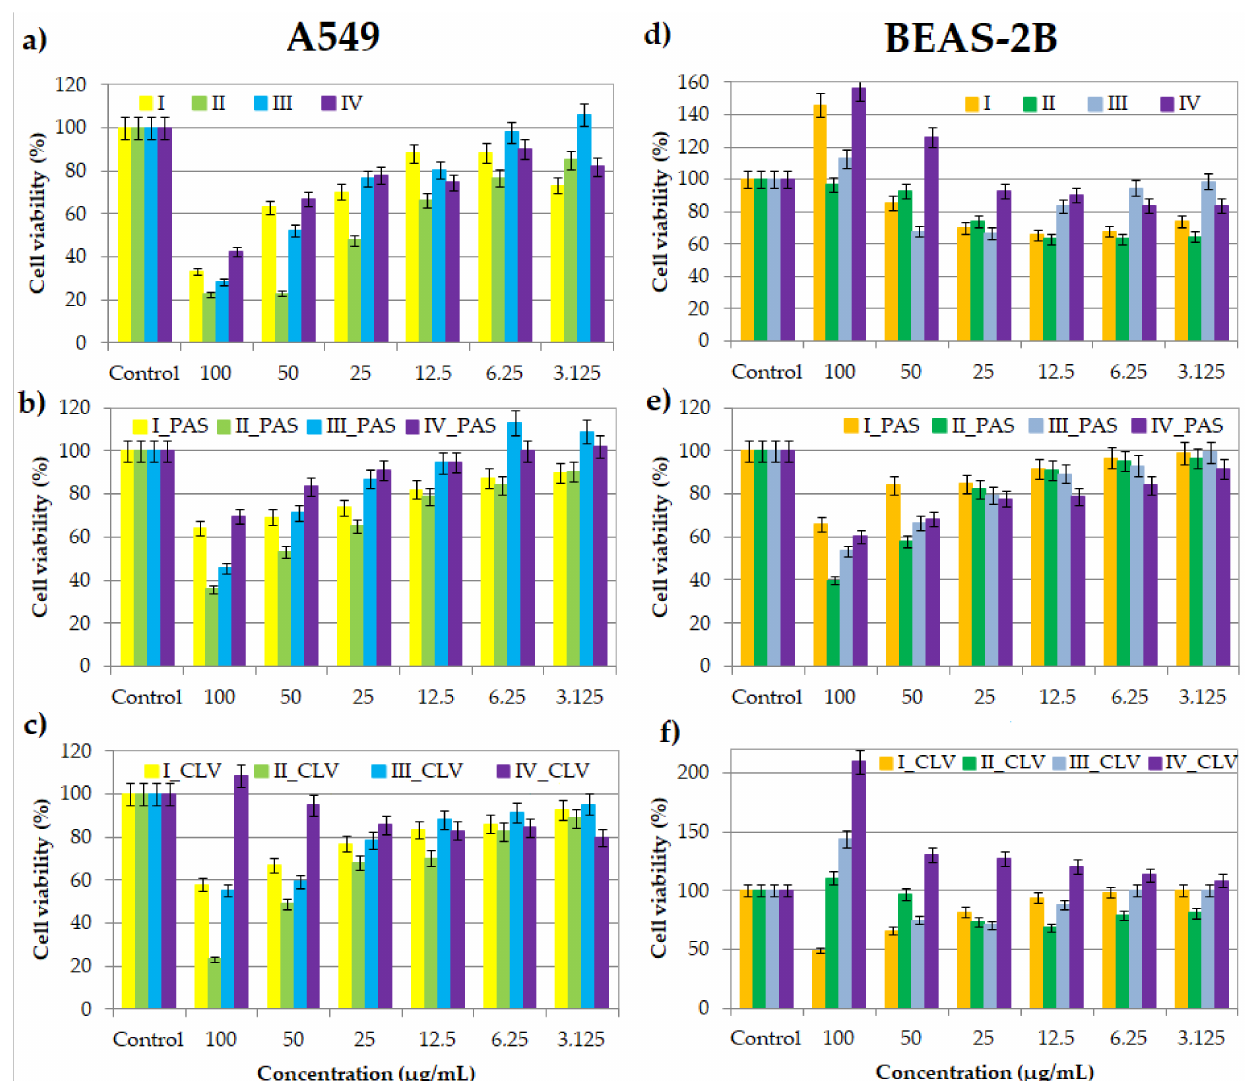
Figure 2. Cell viability of graft copolymers I, II, III and IV ( a , d ), and their conjugates with PAS ( b , e ) and CLV ( c , f ) at different concentrations for treatment of A549 and BEAS-2B cell lines, after 72 h of incubation in comparison to the untreated controls